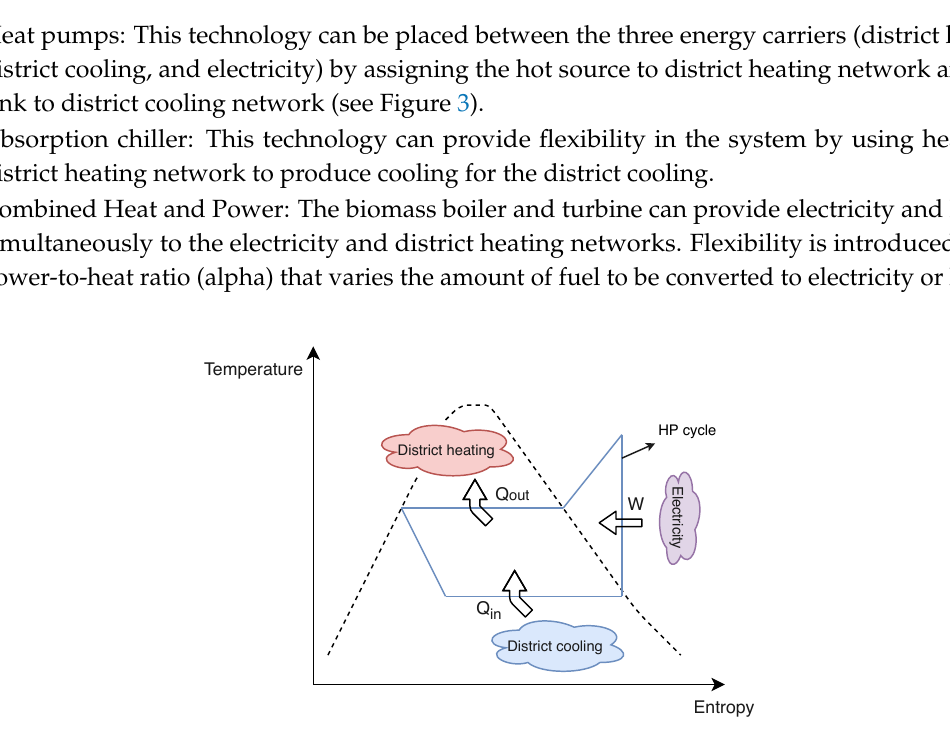
Figure 3. Heat pumps’ thermodynamic cycle in district heating and district cooling coupled